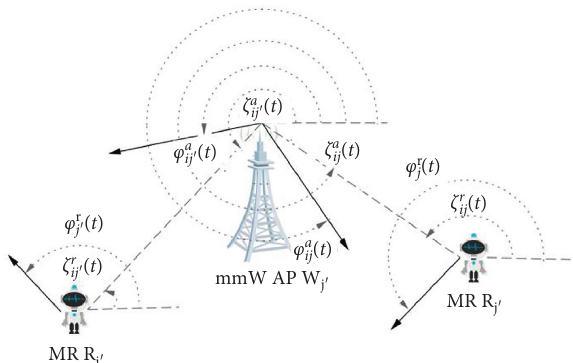
Figure 2: Illustration of the angles between the mmW AP and MRs in the transmission.